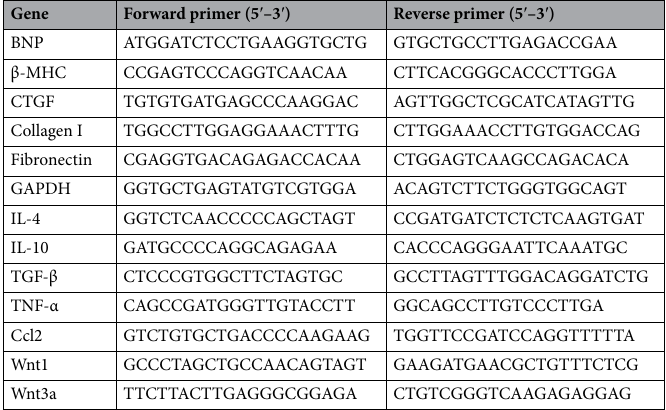
Table 2. Primers for quantitative real time polymerase chain